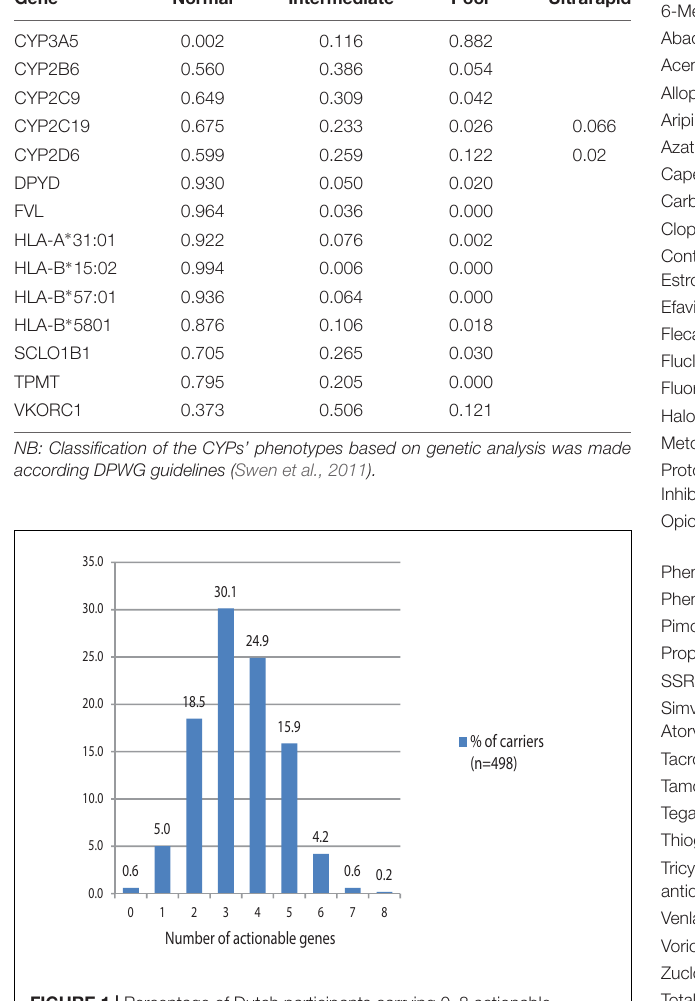
FIGURE 1 | Percentage of Dutch participants carrying 0–8 actionable genotypes.